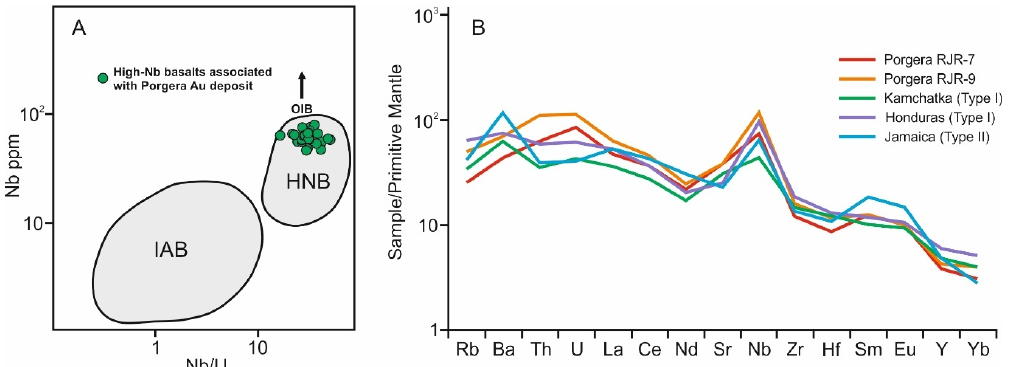
Figure 14. ( A ) Variations of Nb (ppm) versus Nb/U ratio in mafic alkaline rocks associated with Porgera Au deposit (PNG). Fields of island-arc basalts (IAB) and high-Nb basalts (HNB) are modified from [58,131]. ( B ) Primitive mantle-normalized trace element patterns of representative Porgera alkaline rocks (samples RJR-7 and RJR-9 from [214]) compared with Type I HNBs from Kamchatka [52] and Honduras [131] and Type II HNB from Jamaica [129]. Normalizing values are from [104]. Type I HNBs display N-MORB-like Sr–Nd–Pb isotopic signature, while Type II HNB was most probably derived from isotopically enriched, OIB-like mantle sources [153]. Please see text for fur- ther discussion of HNB origins.